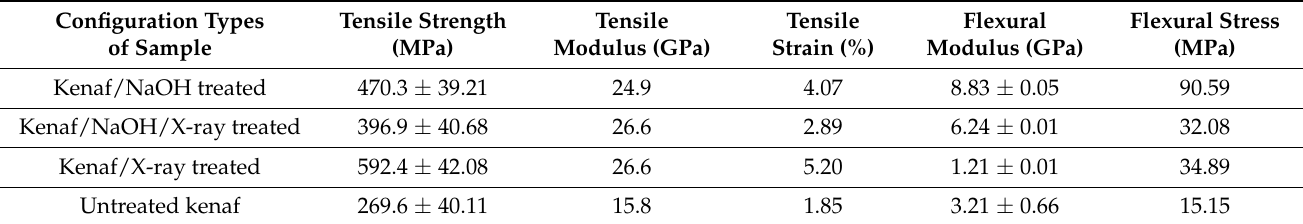
Table 8. Mechanical properties value of untreated and treated kenaf hybrid composites. Configuration